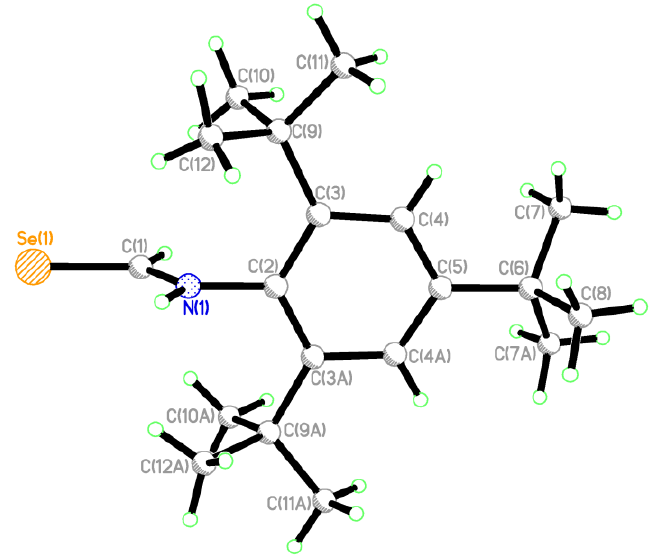
Figure 8. X-ray single crystal structure of 5 . Se(1)-C(1) 1.807(5), N(1)-C(1) 1.324(7), N(1)-C(2) 1.448(6); Se(1)-C(1)-N(1) 125.1(4), C(1)-N(1)-C(2) 125.1(4); Se(1)-C(1)-N(1)-C(2)